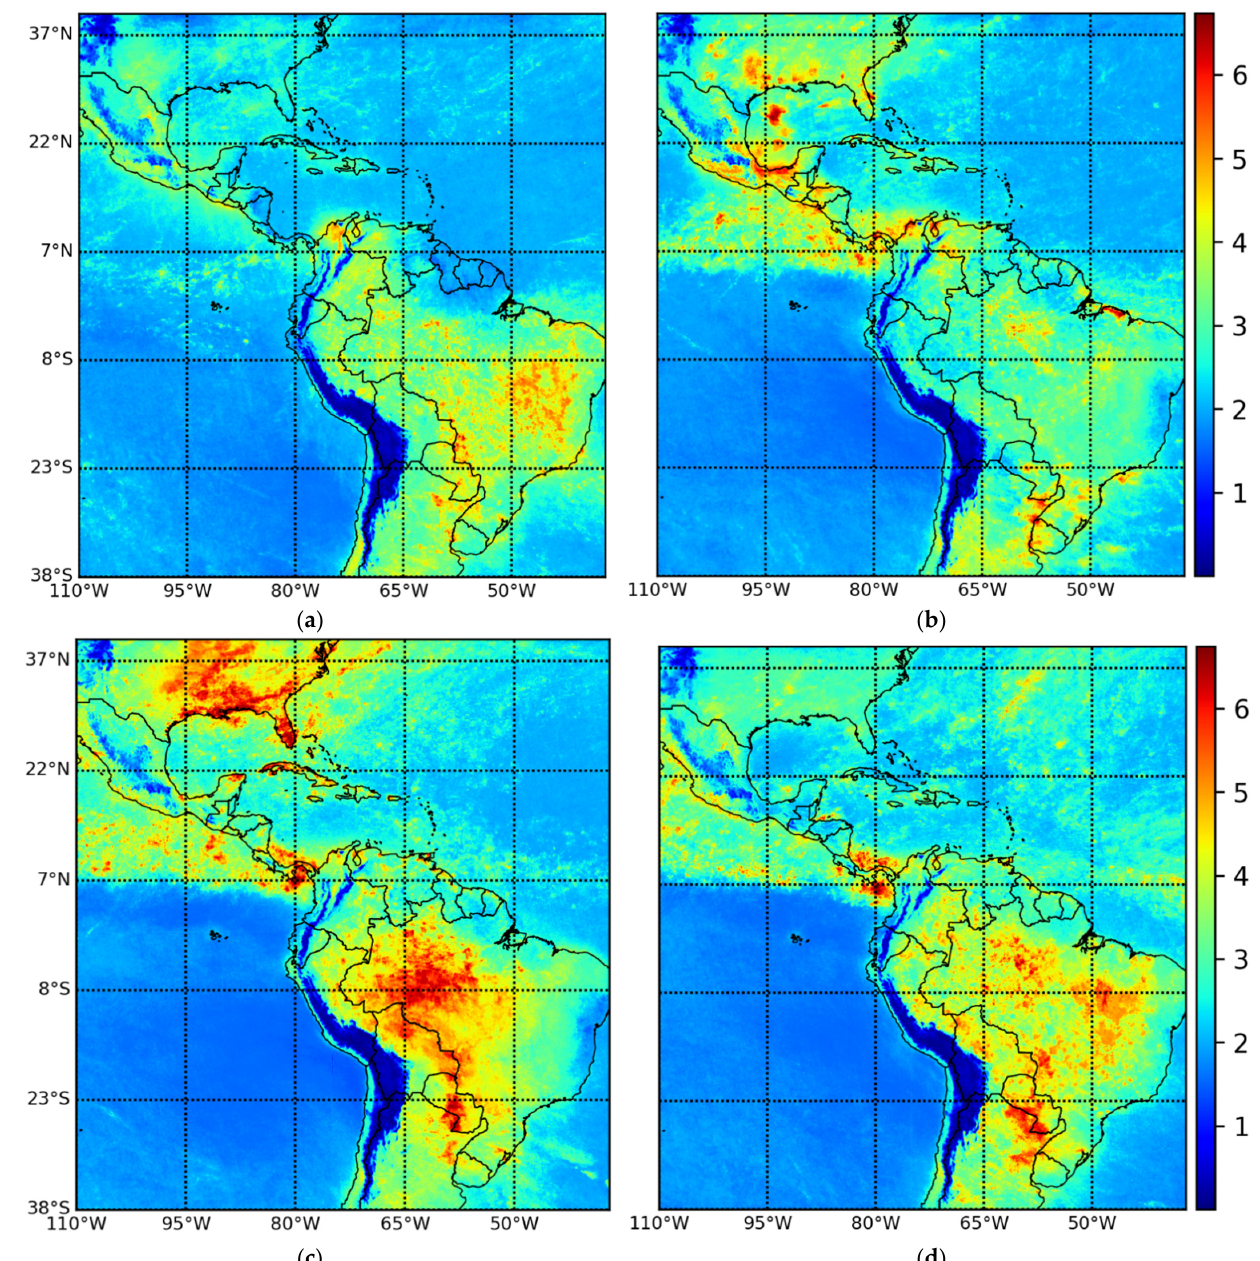
Figure 11. Surface concentration of HCHO in Central and South America in some typical months: ( a ) February; ( b ) May; ( c ) August; ( d ) November. (unit: μ g/m 3 ).